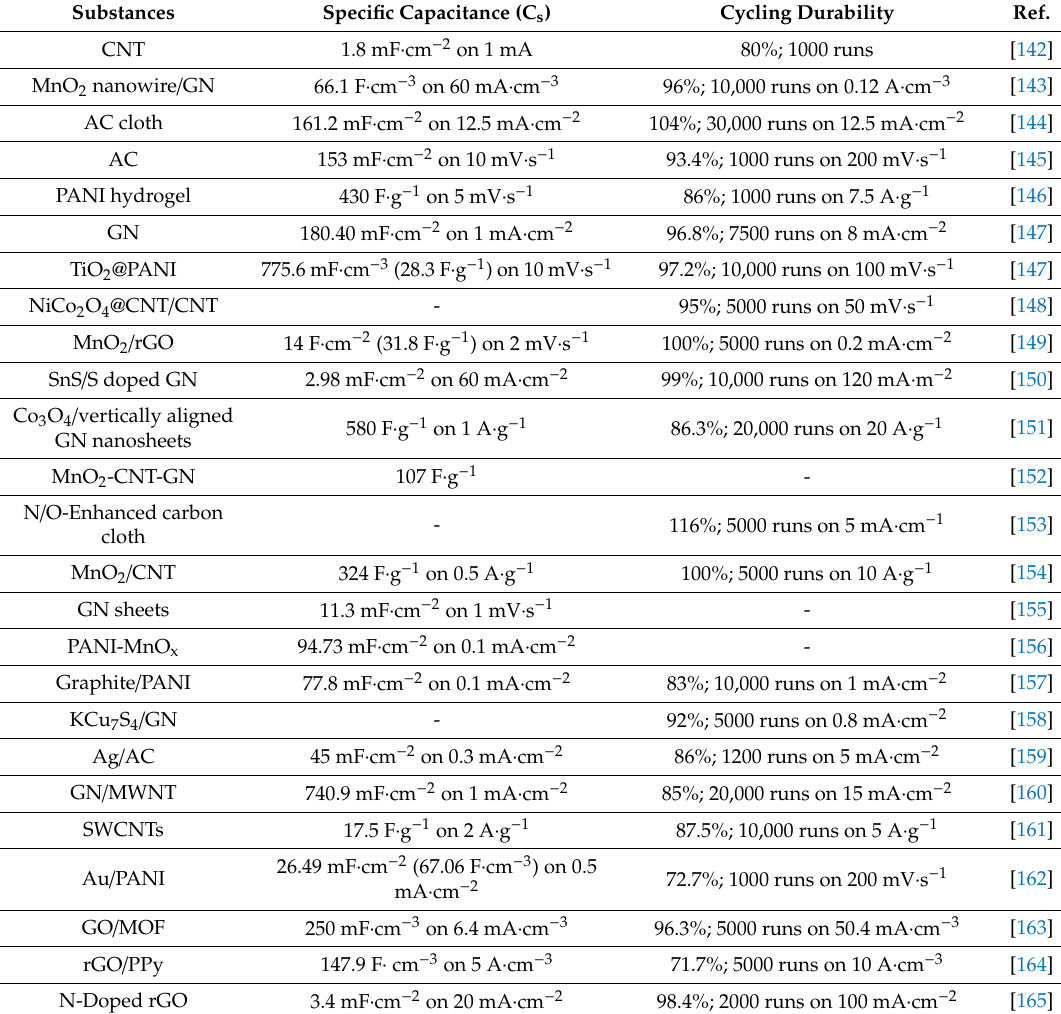
Table 3. Various materials and their supercapacitive